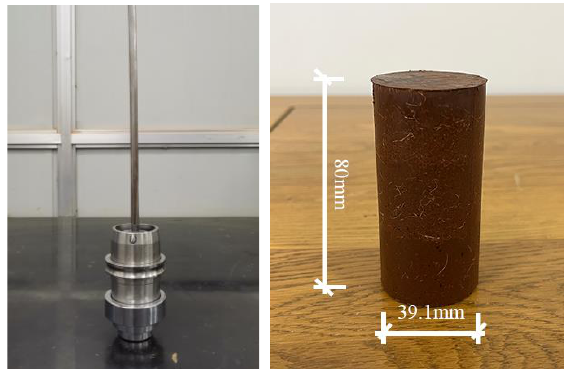
Figure 3. Sample preparation.